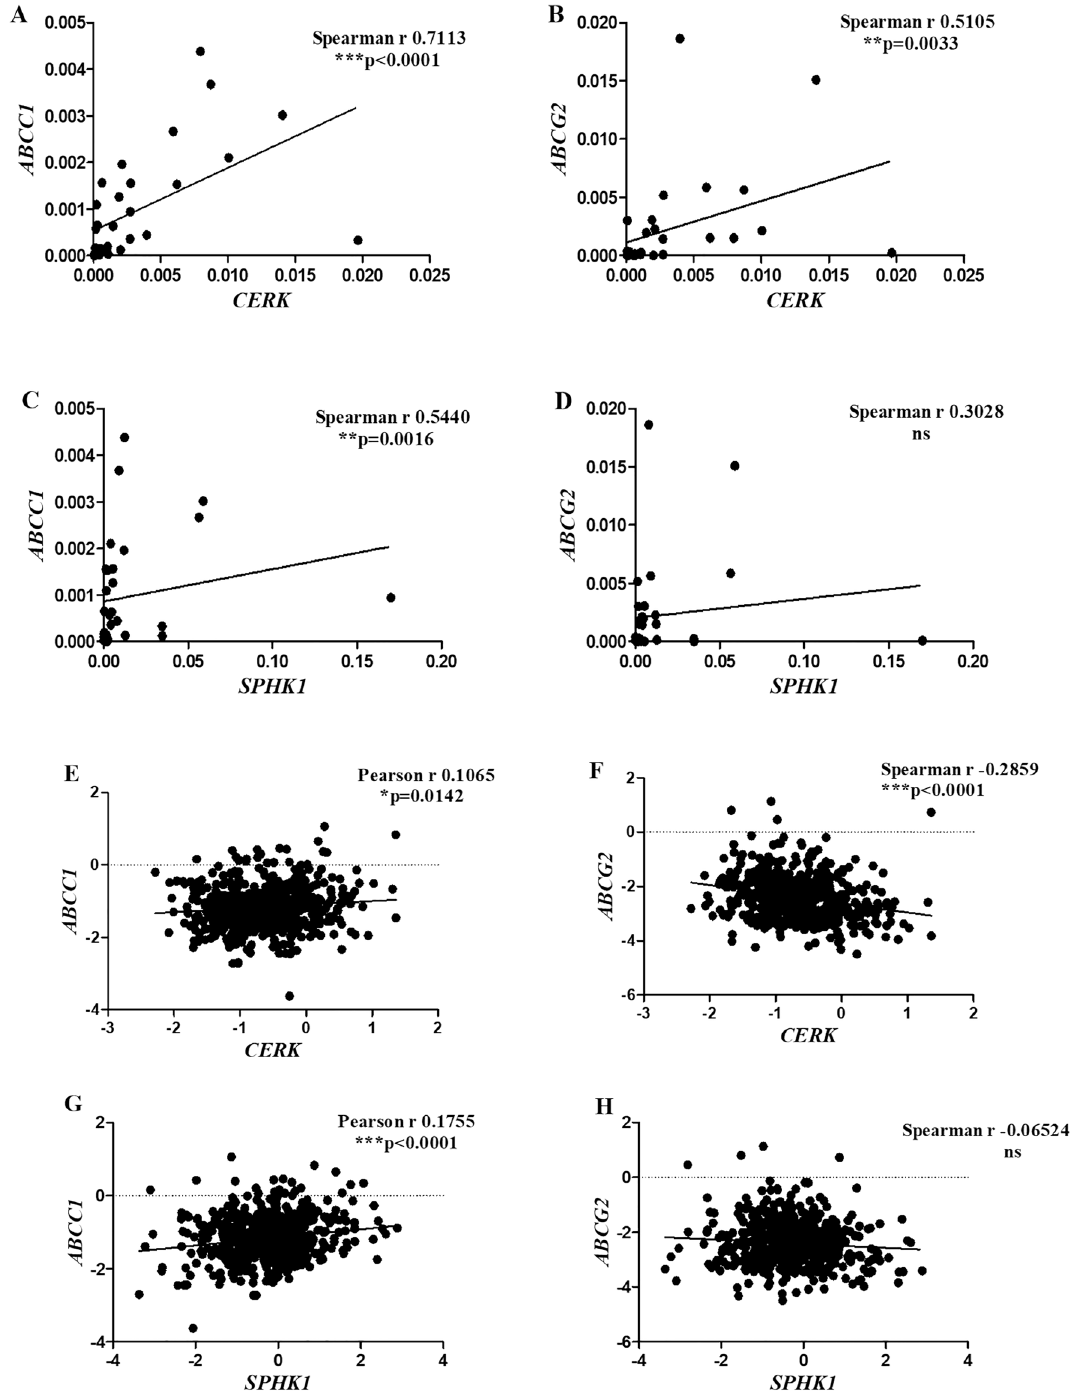
Figure 10. Correlation of CERK with ( A ) ABCC1 , ( B ) ABCG2 and SPHK1 with ( C ) ABCC1 , ( D ) ABCG2 in local cohort and CERK with ( E ) ABCC1 , ( F ) ABCG2 and SPHK1 with ( G ) ABCC1 , ( H ) ABCG2 in TCGA